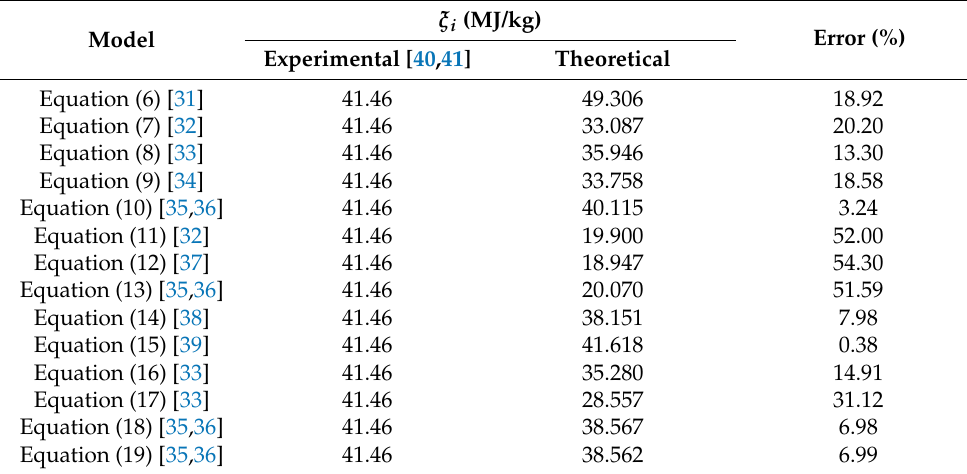
Table 1. Accuracy of models to predict higher heating value of waste polystyrene foam.